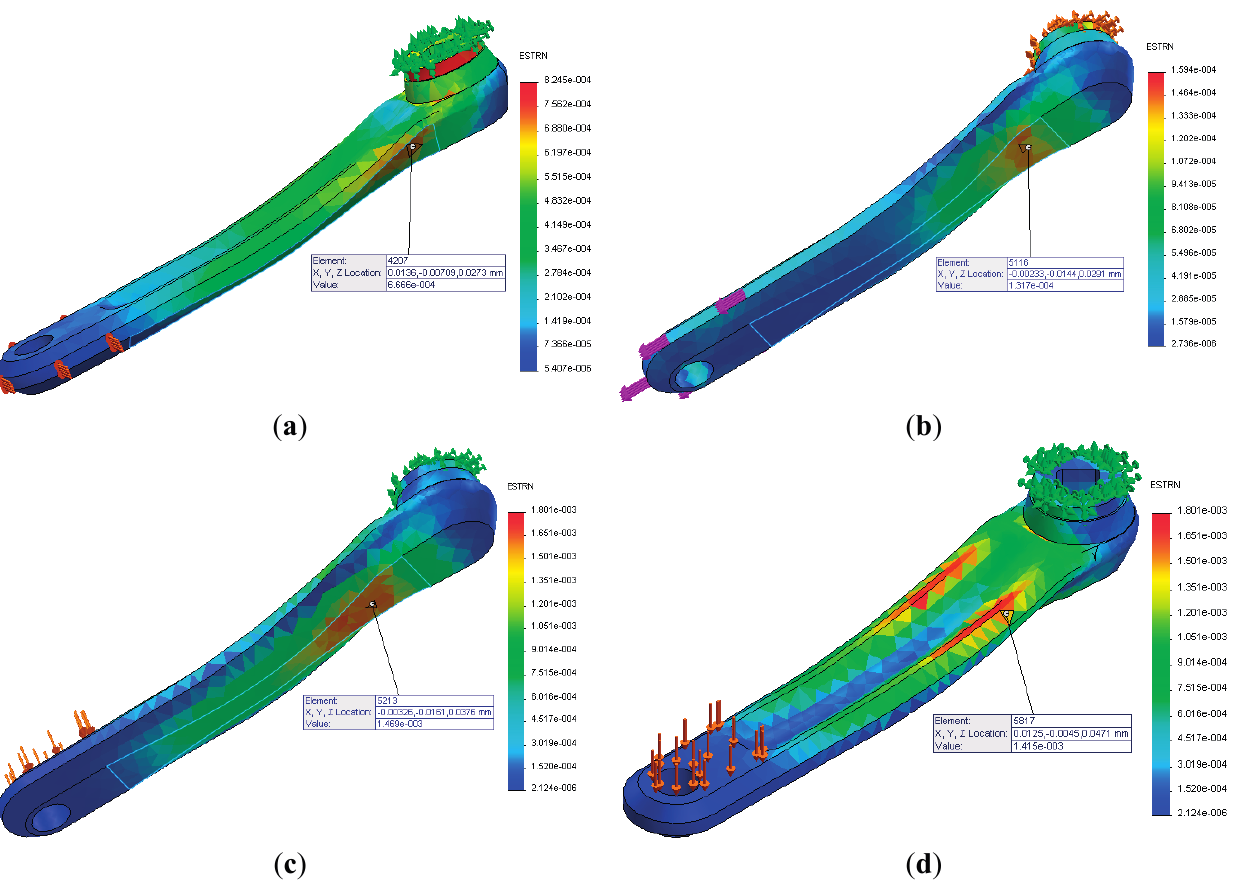
Figure 10. Static simulations results for 800N ( a ) perpendicular; ( b ) parallel; ( c ) lateral; ( d ) lateral loading.